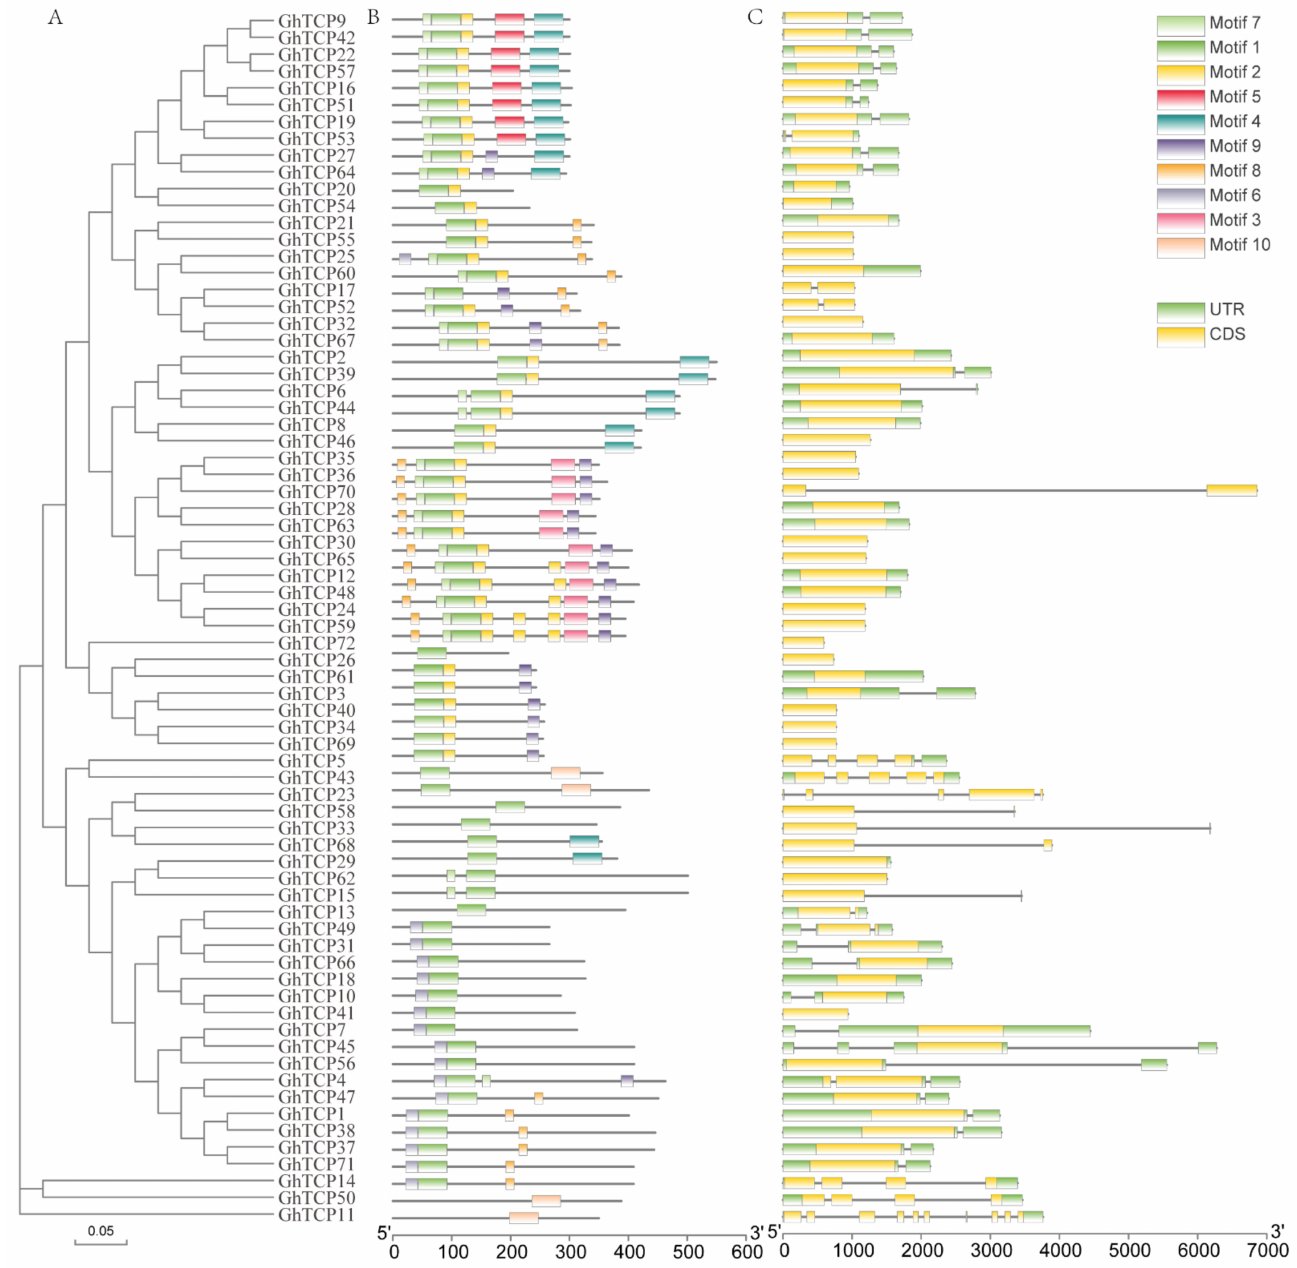
Figure 2. Phylogenetic analysis, exon-intron organization, and motif compositions of G. hirsutum TCP genes. ( A ) An evolutionary tree of all TCP transcription factors in G. hirsutum was constructed using the Neighbor-Joining method, and bootstrapped tests were performed with 1000 iterations. ( B ) Identification of conserved protein motifs in the TCP family was performed using the MEME program. Each pattern has a distinctive color. ( C ) Exon-intron organization of the TCP genes of G. hirsutum (ZM24). The green boxes represent exons and black lines indicate